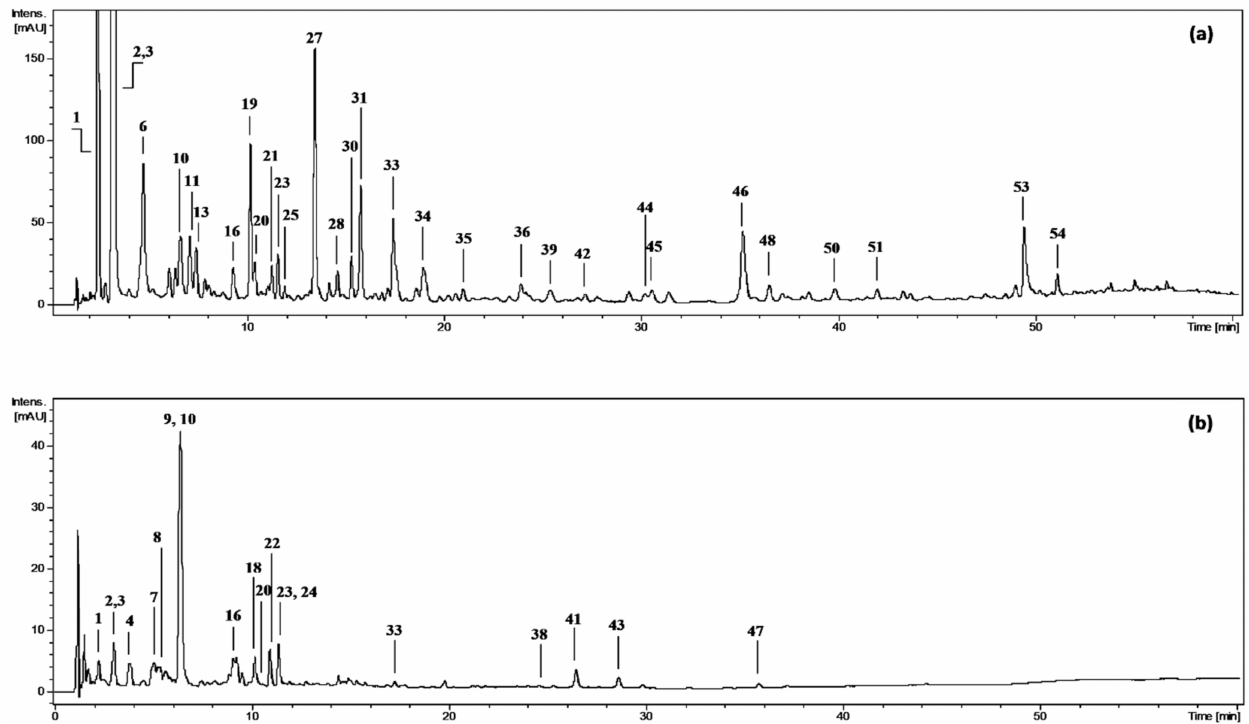
Figure 1. Representative UHPLC chromatograms at 280 nm of ( a ) diethyl ether fraction from dried fruits of Prunus spinosa , DEFD, and ( b ) n -butanol fraction from dried fruits, BFD. Peak numbers refer to those implemented in Table S1 (Supplementary